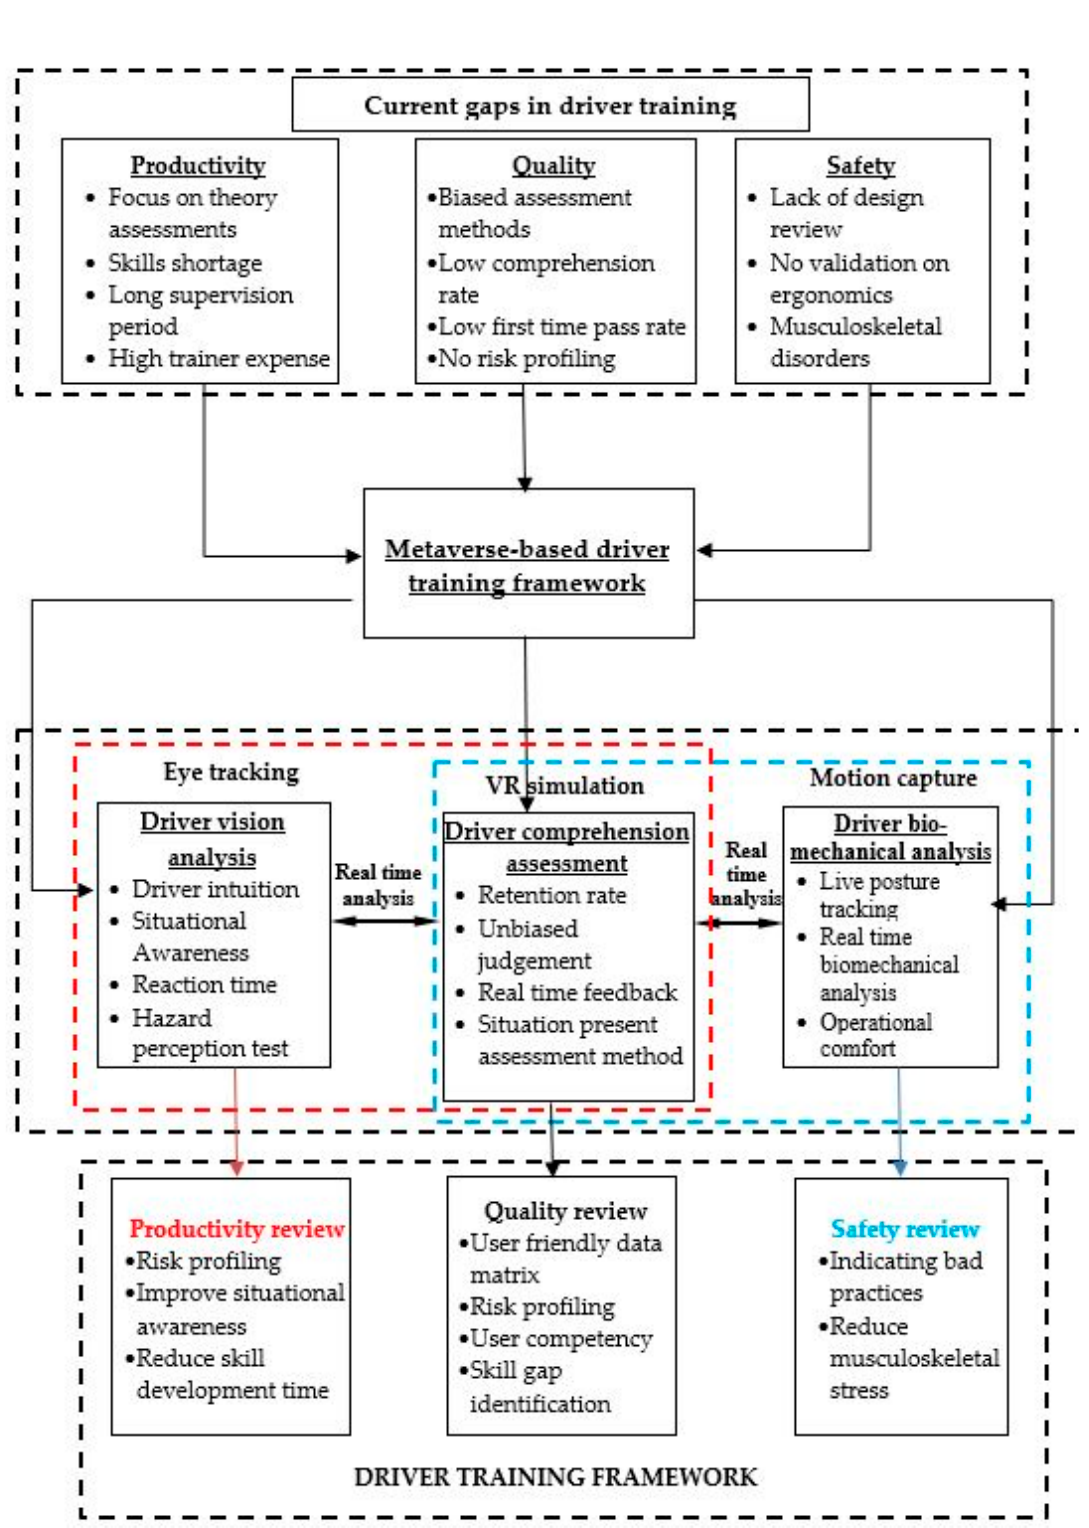
Figure 1. Metaverse-based driver training